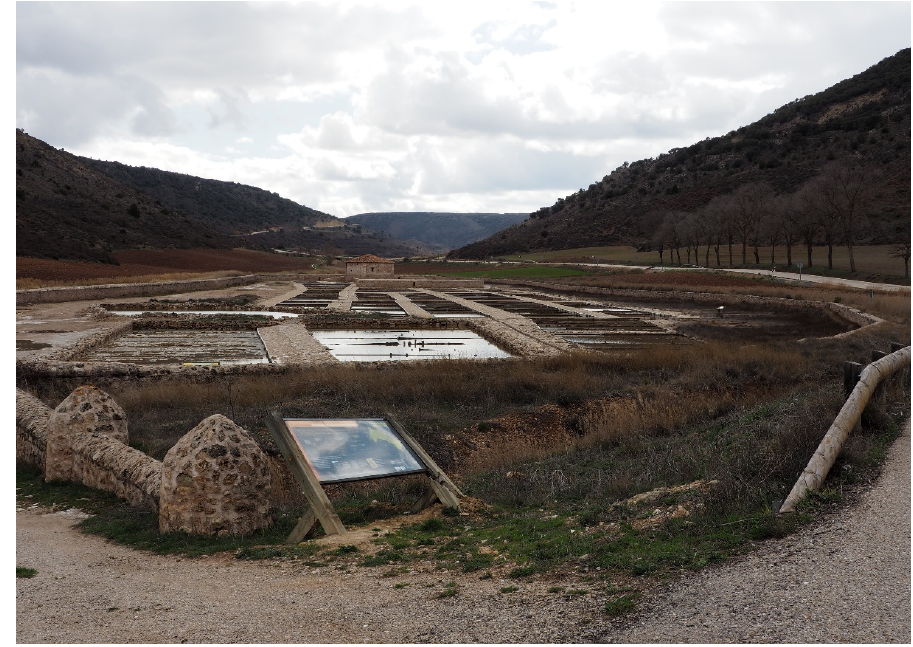
Figure 5. Remains of salt mines in Saelices de la Sal. Source: The